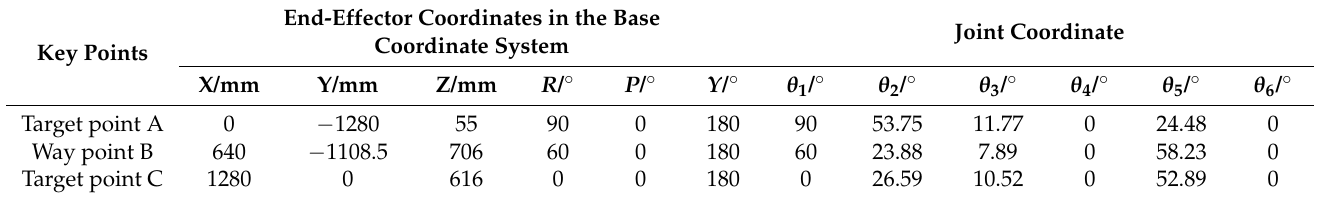
Figure 5. The path planning of loading operation: ( a ) graphic model, ( b ) Y-Z diagrammatic sketch. The coordinates of the path’s key points A, B and C are shown in Table 4. Table 4. Coordinates of the path’s key points.